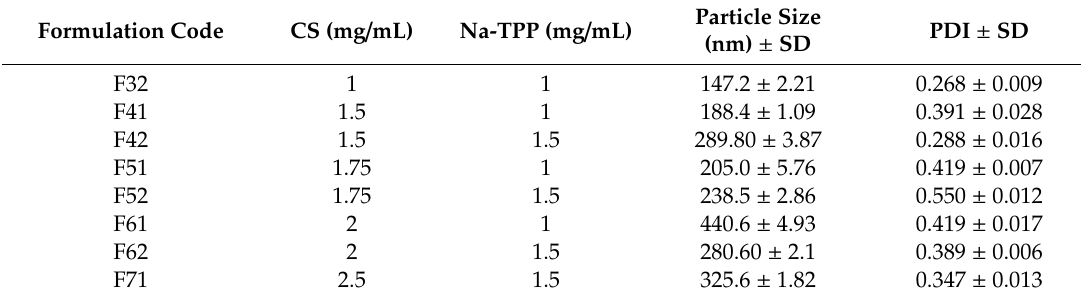
Table 1. Optimization of chitosan